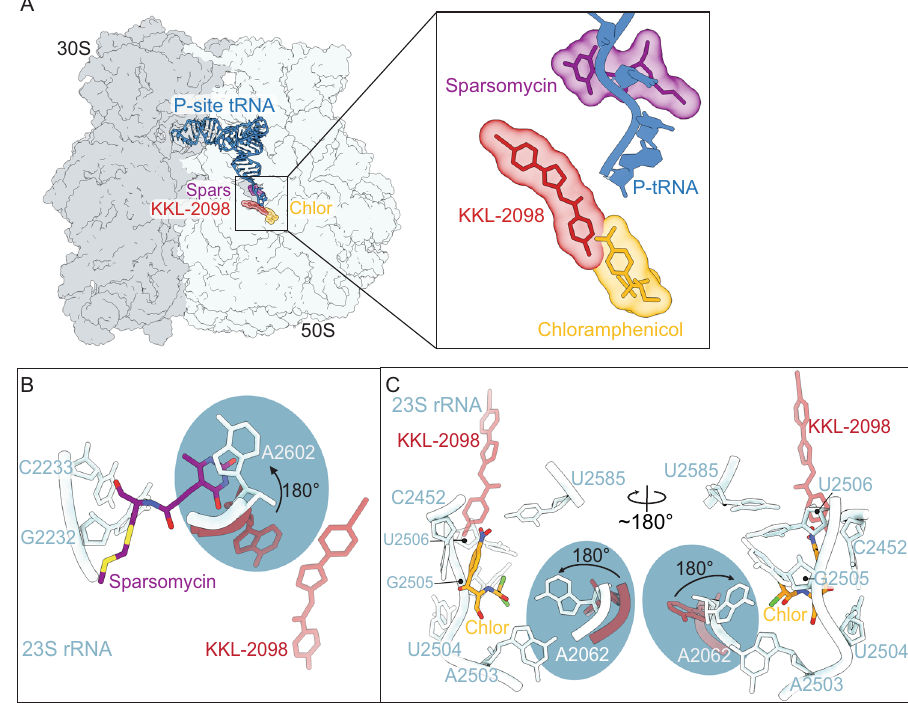
Fig. 5 Comparison of the position of KKL-2098 to other PTC inhibitors. A Overview of the bacterial ribosome showing the position of sparsomycin (PDB 1NJM), chloramphenicol (PDB code 6ND5) and KKL-2098. B Inset view of the interactions of PTC nucleotides with sparsomycin. The nucleobase of 23S rRNA A2602 moves ~180° upon sparsomycin binding. KKL-2098 and A2602 in the absence of sparsomycin binding are shown in red. C Inset view of the interactions of PTC nucleotides with chloramphenicol. The nucleobase of 23S rRNA A2062 also moves ~180° upon chloramphenicol binding. KKL-2098 and A2062 in the absence of chloramphenicol binding are shown in